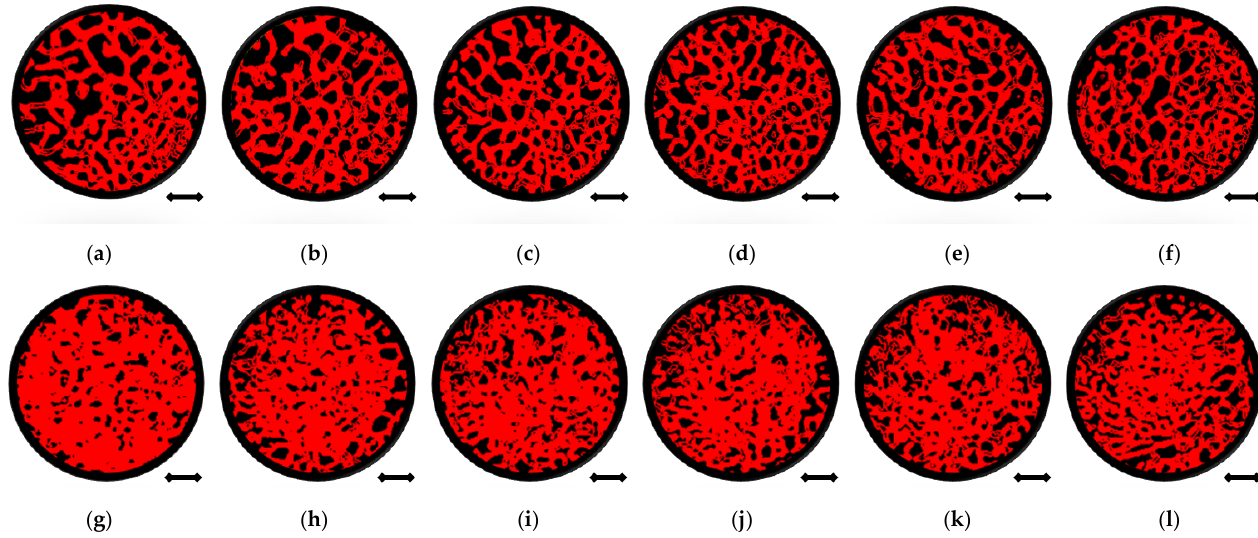
Figure 4. Quantitative micro-CT analysis of femoral head bone samples microarchitecture before and after mechanical embedding of the MSC-Scaffold prototype. Views of bone samples cross-sections below of the reference plane: before the MSC-Scaffold embedding ( a ) 0 mm, ( b ) 0.5 mm, ( c ) 1 mm, ( d ) 1.5 mm, ( e ) 2 mm, ( f ) 2.5 mm, and after MSC-Scaffold embedding ( g ) 0 mm, ( h ) 0.5 mm, ( i ) 1 mm, ( j ) 1.5 mm, ( k ) 2 mm, ( l ) 2.5 mm; bar = 2